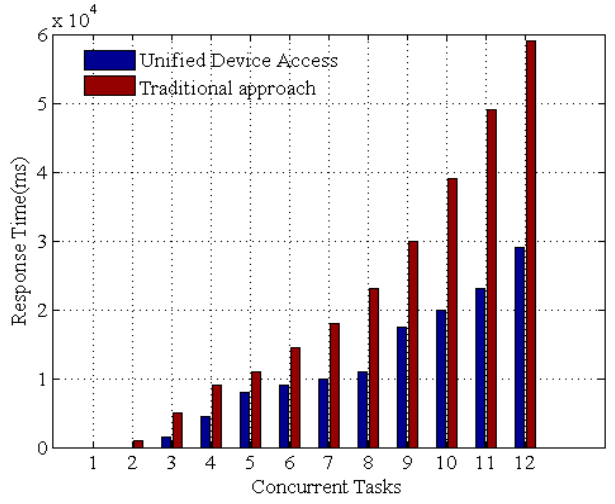
Figure 16. The response time for OSGi framework against native traditional Java code approach.